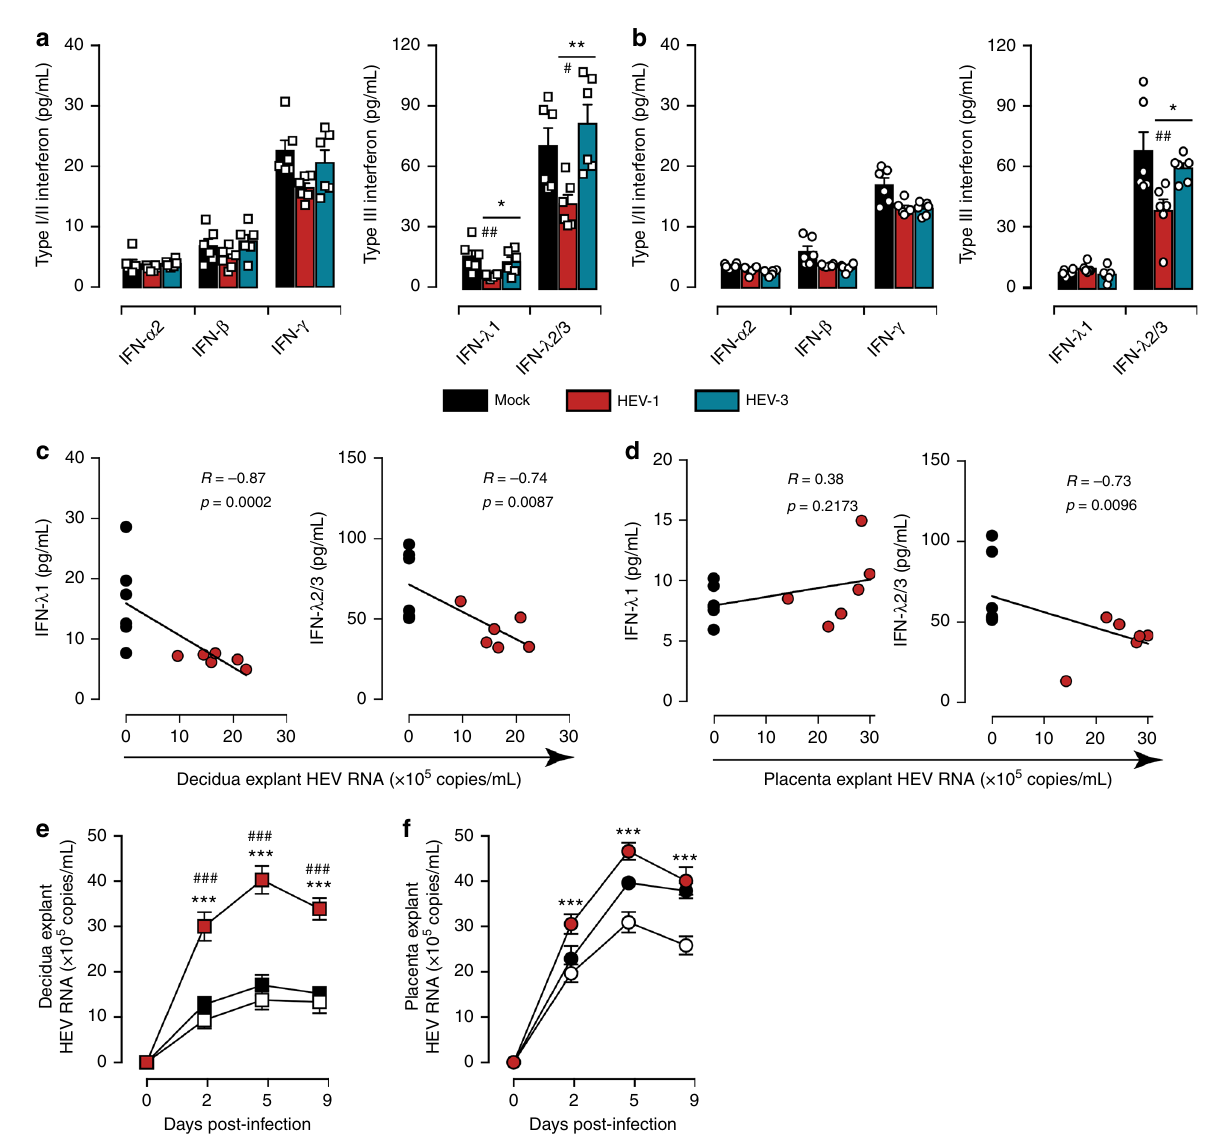
Fig. 5 HEV-1 replication is associated with a decrease in type III interferon levels. a , b Type I/II and type III interferon secretion from explants established from either decidua a or placenta b , measured by cytometric bead array in culture supernatants 2 days after infection with HEV-1 (red) or HEV-3 (cyan). Black bars represent mock-infected tissues. Data represent mean values± S.E.M. of six independent donors. * denotes a statistical comparisons made between HEV-1 and HEV-3 infected tissue, and # represents a statistical comparison between mock-infected and HEV-1 or HEV-3 infected tissue. */# P < 0.05; **/## P < 0.01. c , d Correlation between IFN- λ 1, or IFN- λ 2/3 secretion and viral production in the decidua c and placenta d 2 days after HEV-1 infection. Black and red points represent mock-, and HEV-1-infected tissues, respectively. The Spearman ’ s rank correlation test P -value and R -coef fi cient are indicated in each graph. e , f Kinetics of HEV virus production from explants established from the decidua e and placenta f , infected with HEV-1. After infection, tissues were left untreated (CTRL, in red), treated with IFN- λ 1 (100 ng/mL, in black) or treated with IFN- λ 2 (100 ng/mL, in white). RNA levels were then measured in tissue culture supernatants by RT-qPCR. Data represent means values ± S.E.M. of three independent donors. * denotes a statistical comparison between CTRL- and IFN- λ 2-treated infected tissues. # denotes a statistical comparison between CTRL- and IFN- λ 1-treated infected tissues. ***/### P < 0.001 by repeated measures ANOVA with Tukey post hoc test a , b and two-way ANOVA with Bonferroni post hoc test e ,